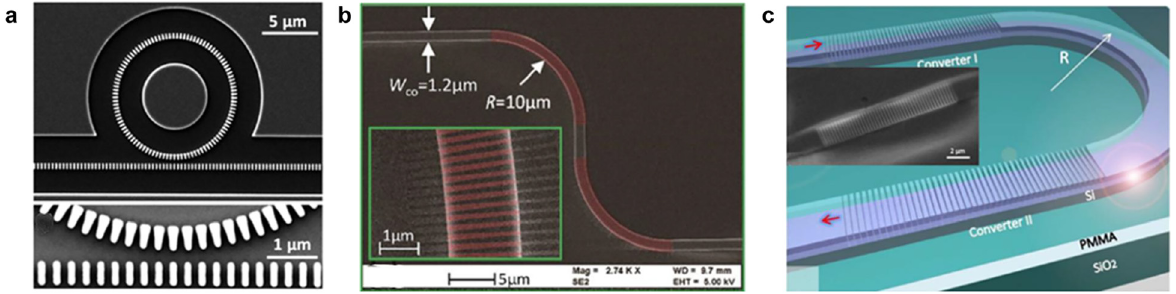
Figure 8: (a), (b) Trapezoidal SWG structures inside the bend and (c) tapered SWG structures before and after the bend to compensate the lateral shift of the mode. Reproduced with permission from Refs. [49 –